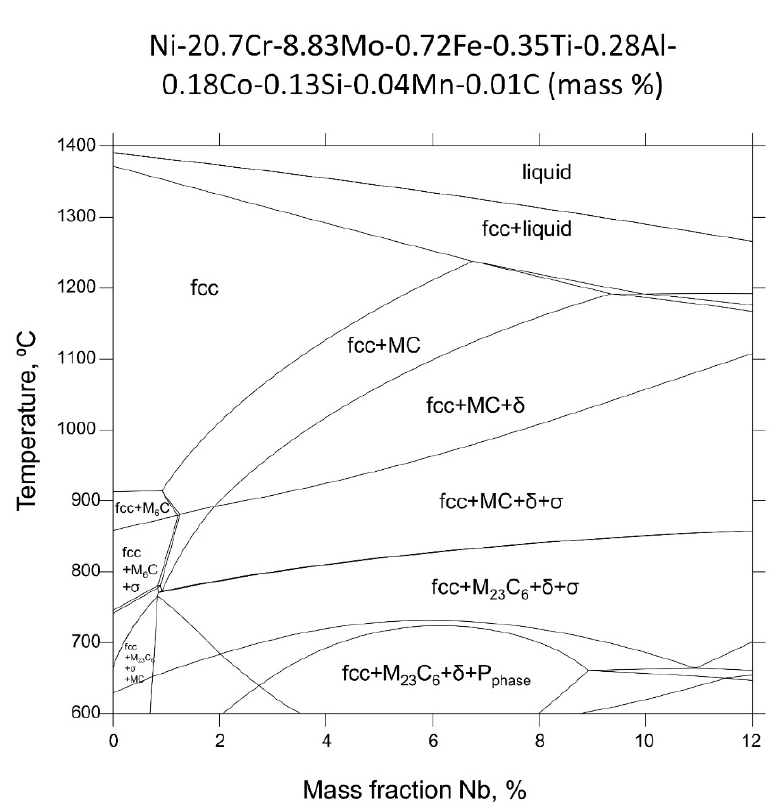
Figure 1. A steady-state Nb isopleth section of IN625 phase diagram constructed assuming a composition of Ni-20.7Cr-8.83Mo-0.72Fe-0.35Ti-0.28Al-0.18Co-0.13Si-0.04Mn-0.01C (mass%).